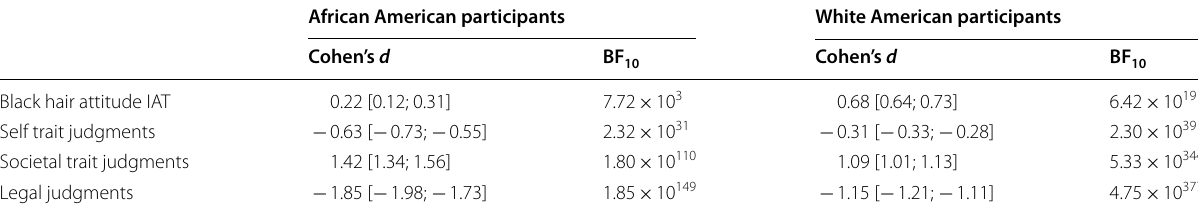
Cohen’s d effect sizes are scored such that more positive scores indicate higher levels of bias in favor of Eurocentric hair texture. 95-percent HDIs (highest density intervals) are reported in square brackets. BF 10 refers to Bayes Factors providing a relative measure of evidence in favor of the alternative hypothesis (μ ≠ 0) over the null hypothesis (μ 0) =